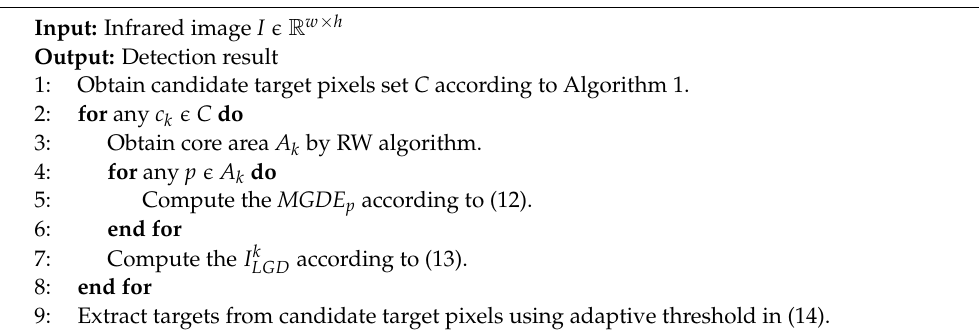
Algorithm 2 The Proposed Detection Method Based on